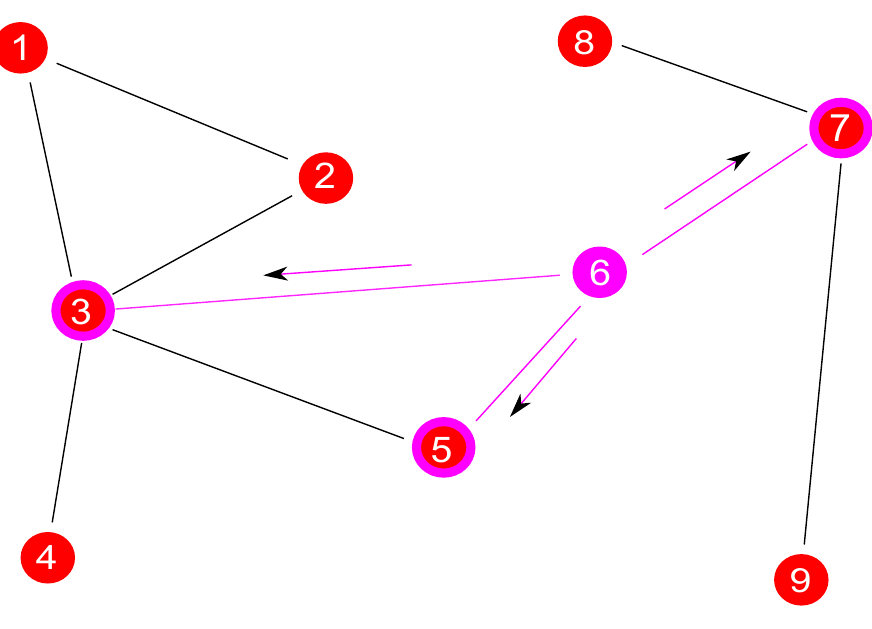
Figure 1. Illustration of a graph. The balls are nodes, which are connected by edges, the segments. Here, nodes have between one and four neighbors. In particular, node 6 diffuses information (e.g., list of transactions) to its neighbors, i.e., nodes 3, 5, and